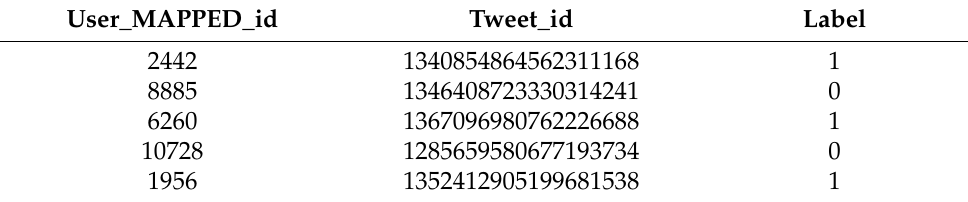
Table 3. The CoAID extended gold standard dataset used for fake news spreader classification. The user mapped ID is a transformation of the original Twitter user ID to preserve privacy. Tweet ID represents the numerical identifier of the tweet as given by the Twitter platform. The third column represents whether a user is a spreader or a real news